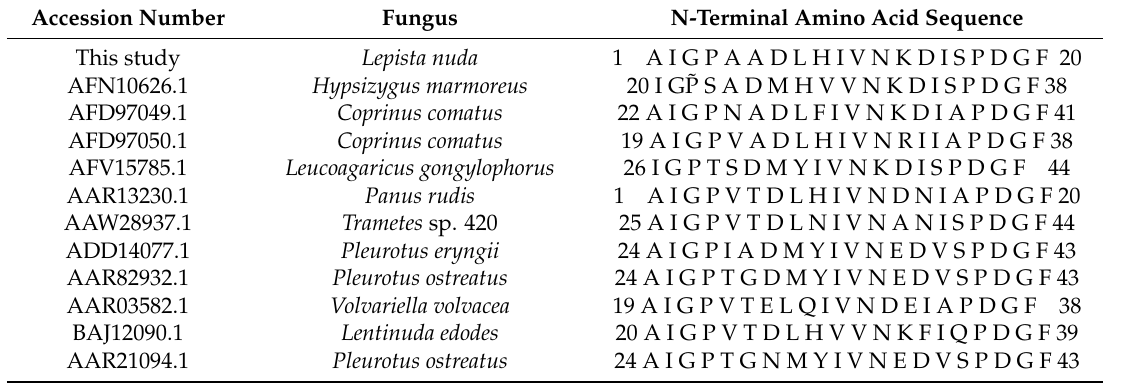
Table 2. Comparison of the N-terminal amino-acid sequences of Lepista nuda laccase and other fungal laccases.